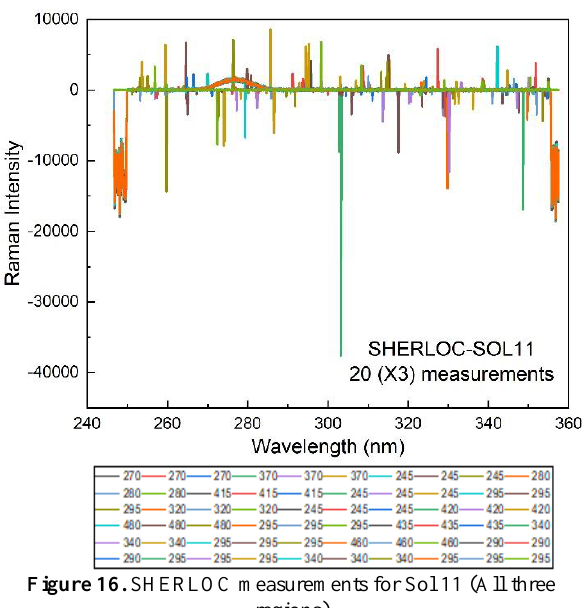
Figure 16. SHERLOC measurements for Sol 11 (All three regions)